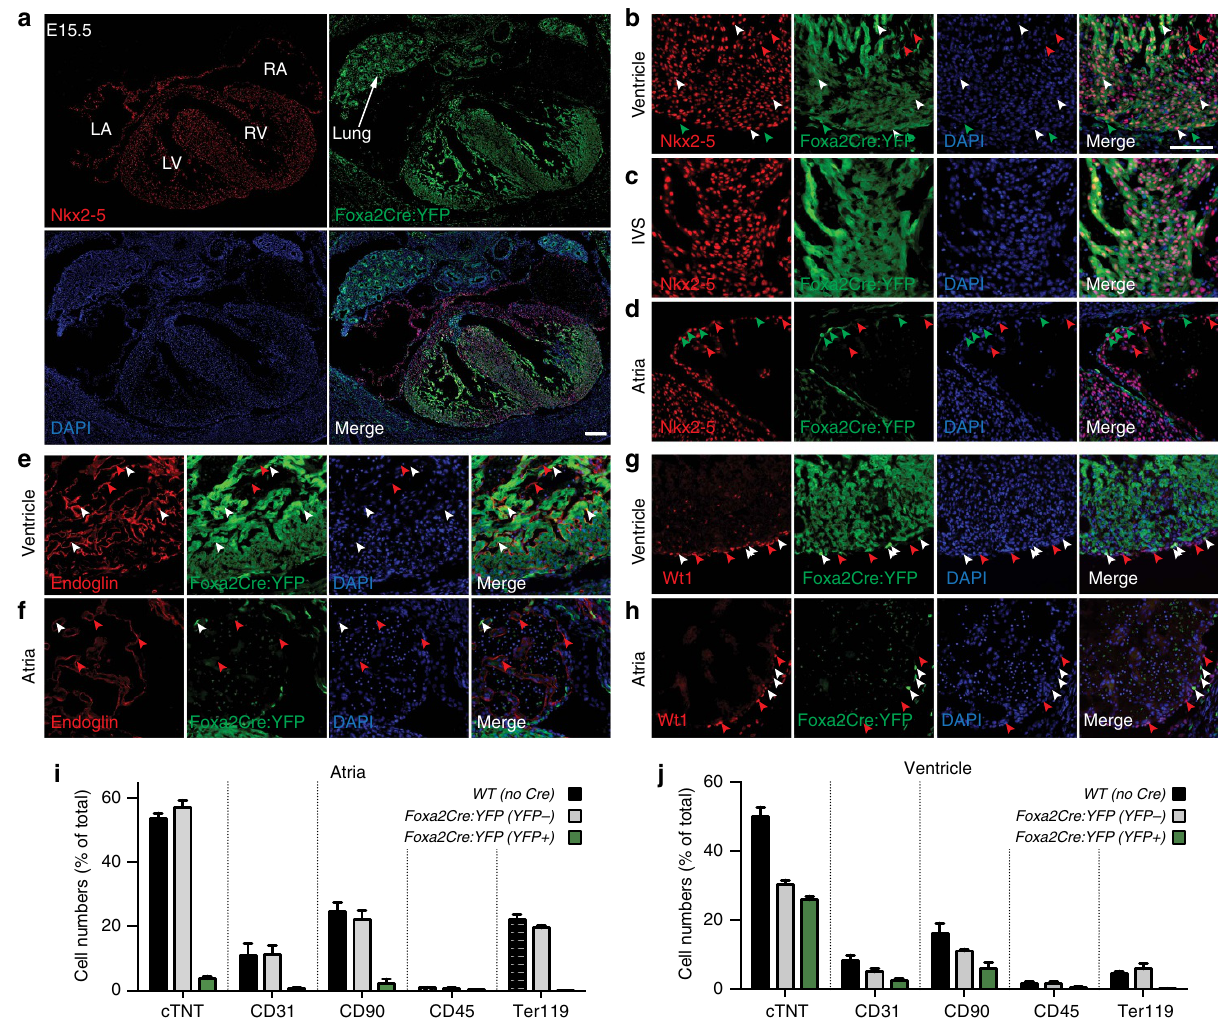
Figure 5 | Contribution of Foxa2-vCPs to the major cardiovascular lineages. ( a ) Heart sections from E15.5 Foxa2Cre:YFP embryos stained with antibodies against YFP and Nkx2–5 to label cardiomyocytes. Tile scan image showing heart and lung. ( b – h ) IF analysis of E15.5 Foxa2Cre:YFP embryos using antibodies against YFP and Nkx2–5 (myocardium, b – d ), Endoglin (endocardium, e , f ) or Wt1 (epicardium, g , h ). Detailed areas of ventricle ( b , e , g ), interventricular septum ( c ) and atria ( d , f , h ) are shown. Arrowheads indicate cells that express the relevant lineage markers alone (red) or that co-express YFP and the relevant lineage marker (white). Images are representative examples from multiple experiments. ( i , j ) Flow cytometry analysis of dissociated cells of atrial ( i ) and ventricular ( j ) chambers of E13.5 Foxa2Cre:YFP hearts with antibodies against cTnT (cardiomyocytes), CD31 (endothelial), CD90 (mesenchymal, haematopoietic, fibroblast, epicardium), CD45 (leukocyte) and Ter119 (erythroid). Data are mean ± s.e.m. of n ¼ 7 hearts. Scale bars, 100 m m. LA, left atria; LV, left ventricle; RA, right atria; RV, right